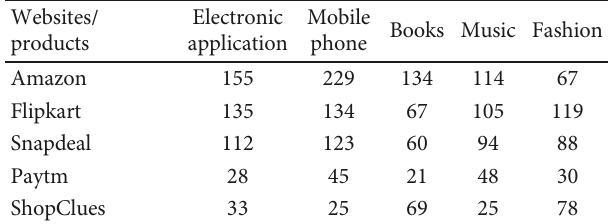
Table 1: Numbers of review data.